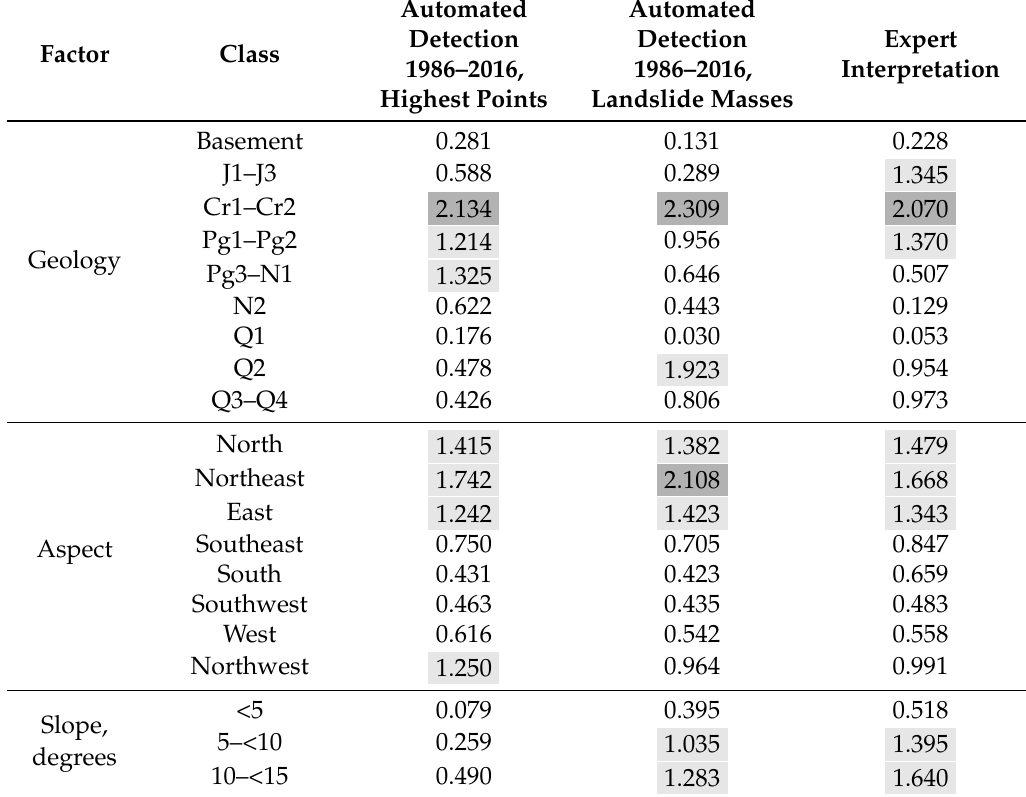
Table 2. Frequency ratio values of the predisposing factors by landslide data source. Classes with frequency ratio values > 1 are more favorable for the development of landslides than the study area on